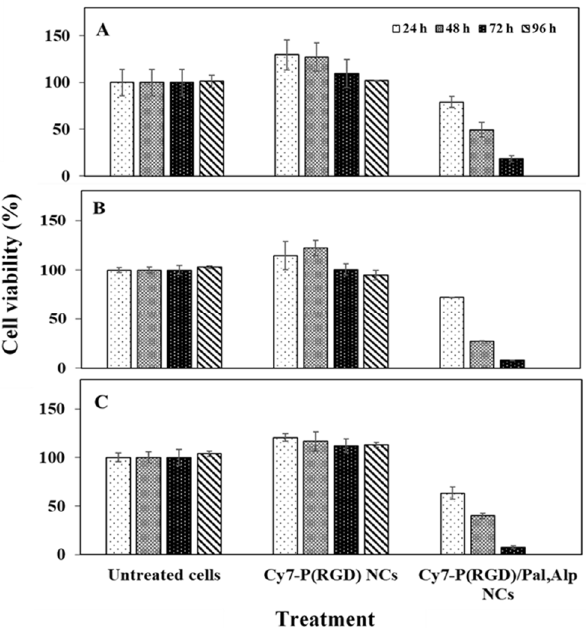
Figure 9. Cell viability of ( A ) MCF-7, ( B ) HCT116 and ( C ) A549 cell lines after exposure to Cy7- P(RGD) NCs measured by XTT assay. Cells (10 4 ) were incubated for 24, 48, 72 and 96 h with hollow and Cy7-P(RGD)/Pal,Alp (2.8 µM of each drug) dispersed in water (0.1 mg/mL)). Untreated cells (positive control with medium) were similarly incubated. Bars denote mean ± standard deviation of six separate samples.